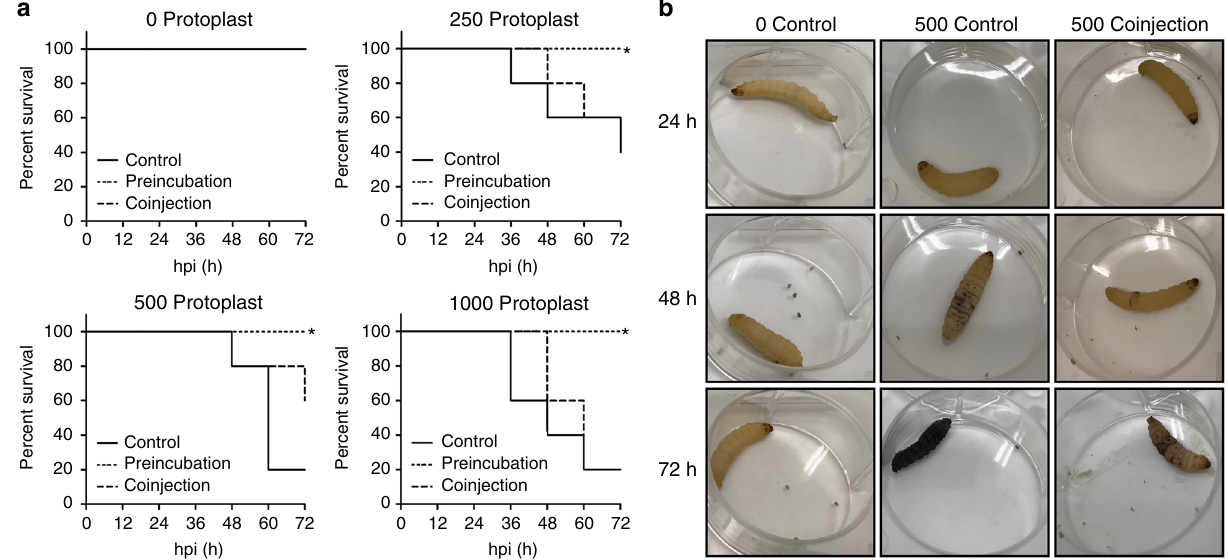
Fig. 6 Survival of G. mellonella larvae infected with S. parasitica after treatment with molecular tweezers. a Each group was injected with the amount of protoplasts of S. parasitica as indicated (0, 250, 500, 1000). The experiment was performed with fi ve larvae per condition. control: injected with protoplasts only; preincubation: protoplasts were preincubated for 1 h with 5 mM molecular tweezers; coinjection: 5 mM molecular tweezers were injected 1 h before injection of protoplasts. Kaplan – Meier curves were performed to compare survival between preincubated or con-injected protoplast with the control group. Pre-incubated protoplasts of S. parasitica are not lethal for larvae (* p < 0.1), while the mortality of co-injected larvae is delayed for all tested concentrations but not statistically signi fi cant ( p > 0.1). b Progress of an infection with S. parasitica exemplarily shown for injections with molecular tweezers only (0 protoplasts, coinjection) and the delay of an infection after coinjection with 500 protoplasts compared to the injection of 500 protoplasts respectively) (Fig. 7c), which indicates a cofactor-mediated release of SpHtp3.